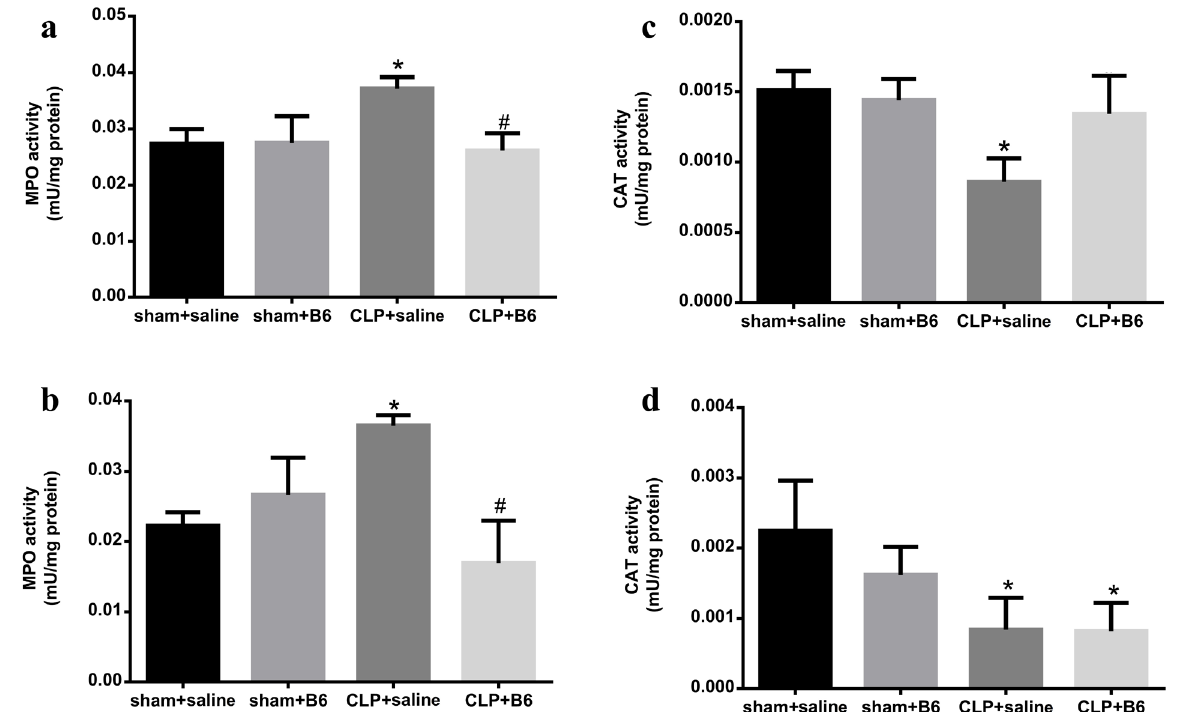
Figure 1 - Myeloperoxidase activity in the lung ( a ) and liver ( b ) and catalase activity in the lung ( c ) and liver ( d ) of rats subjected to polymicrobial sepsis and treated with vitamin B6 (600 mg/Kg). Data is expressed as mean ± standard deviation, analyzed by one- way ANOVA with Tukey post-hoc test . *p < 0.05 compared to sham+saline group and # p < 0.05 compared to ClP+saline